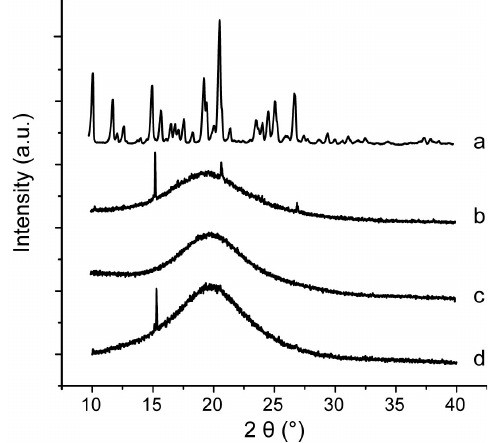
Figure 7. X-ray powder diffractometry of ( a ) pure nimodipine powder, ( b ) physical mixture of nimodipine and carriers, ( c ) S-SMEDDS of nimodipine with acacia and ( d ) S-SMEDDS of nimodipine with maltodextrin.